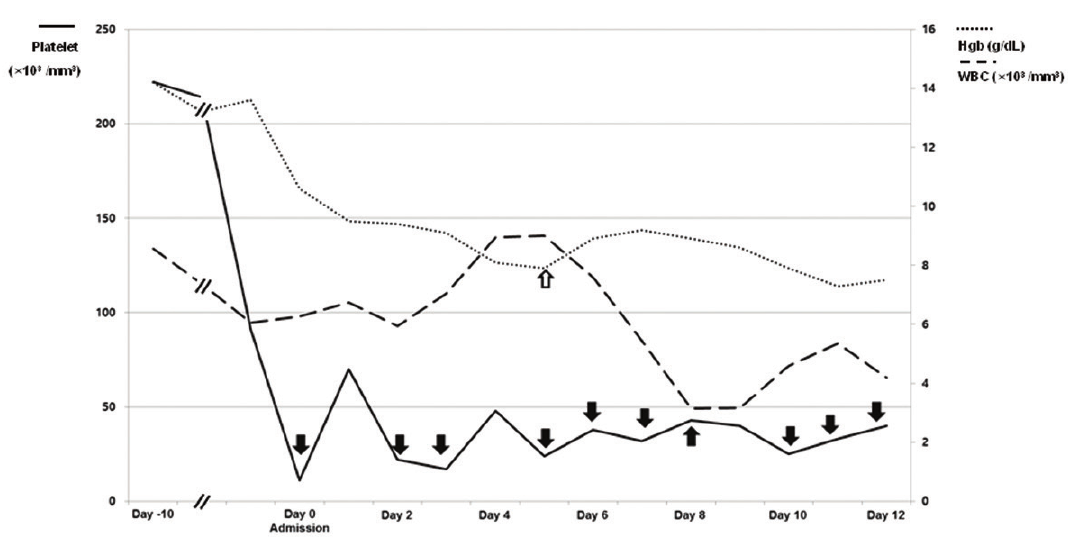
Figure 2: History of transfusions of platelet concentrates (black arrow) and packed red blood cells (vacant arrow) and changes in complete blood counts over the time [white blood cell (WBC), solid line; hemoglobin (Hgb), short dashed dotted line; platelet, long dashed dotted